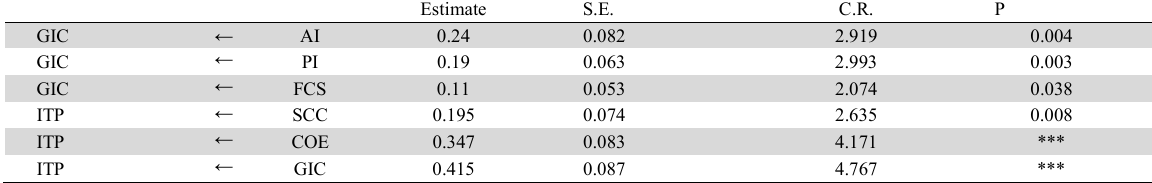
Regression Weights: (Group number 1 - Default model)